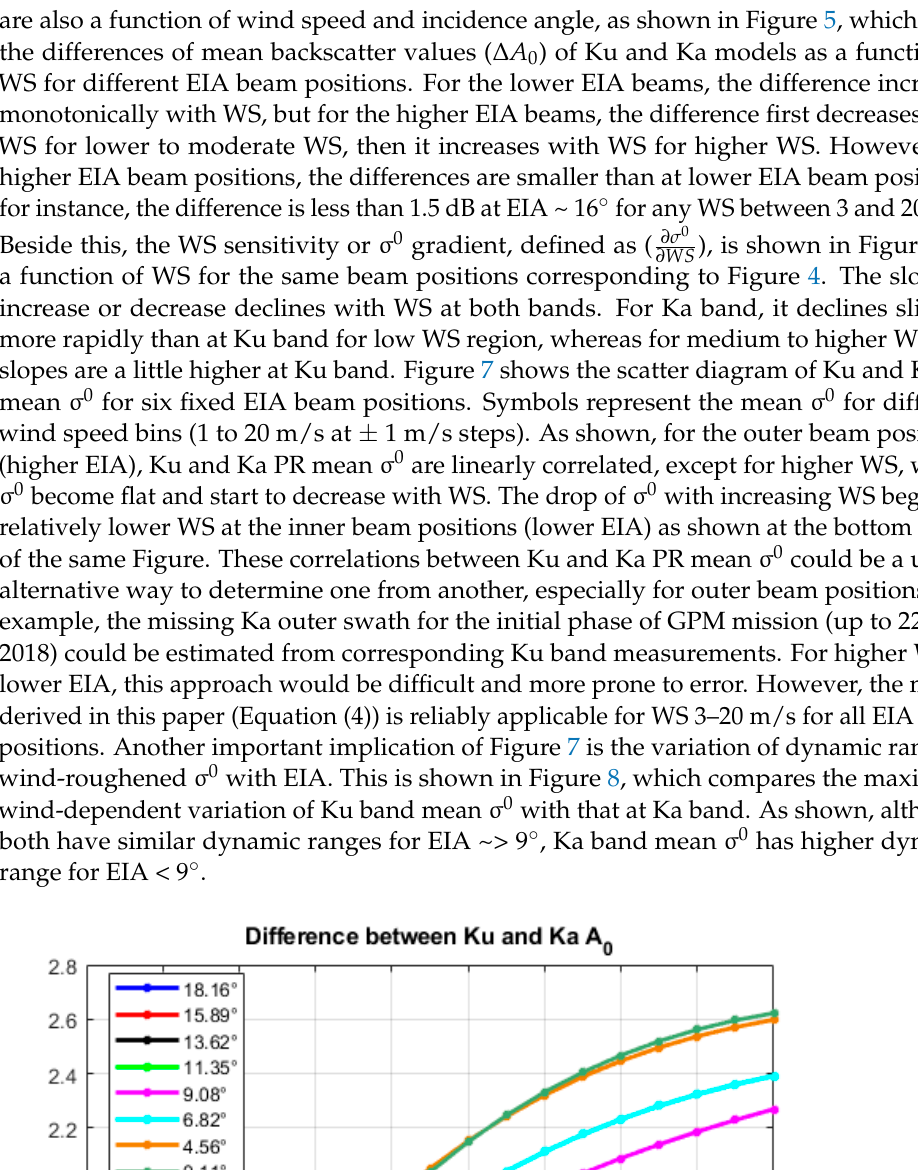
Figure 6. Gradient of KuPR ( left ) and KaPR ( right ) ocean surface normalized radar cross section ( σ 0 ) variation (in dB) as a function of wind speed (3–20 ms − 1 ) at different earth incidence angles (0 ° –18.1 ° ).